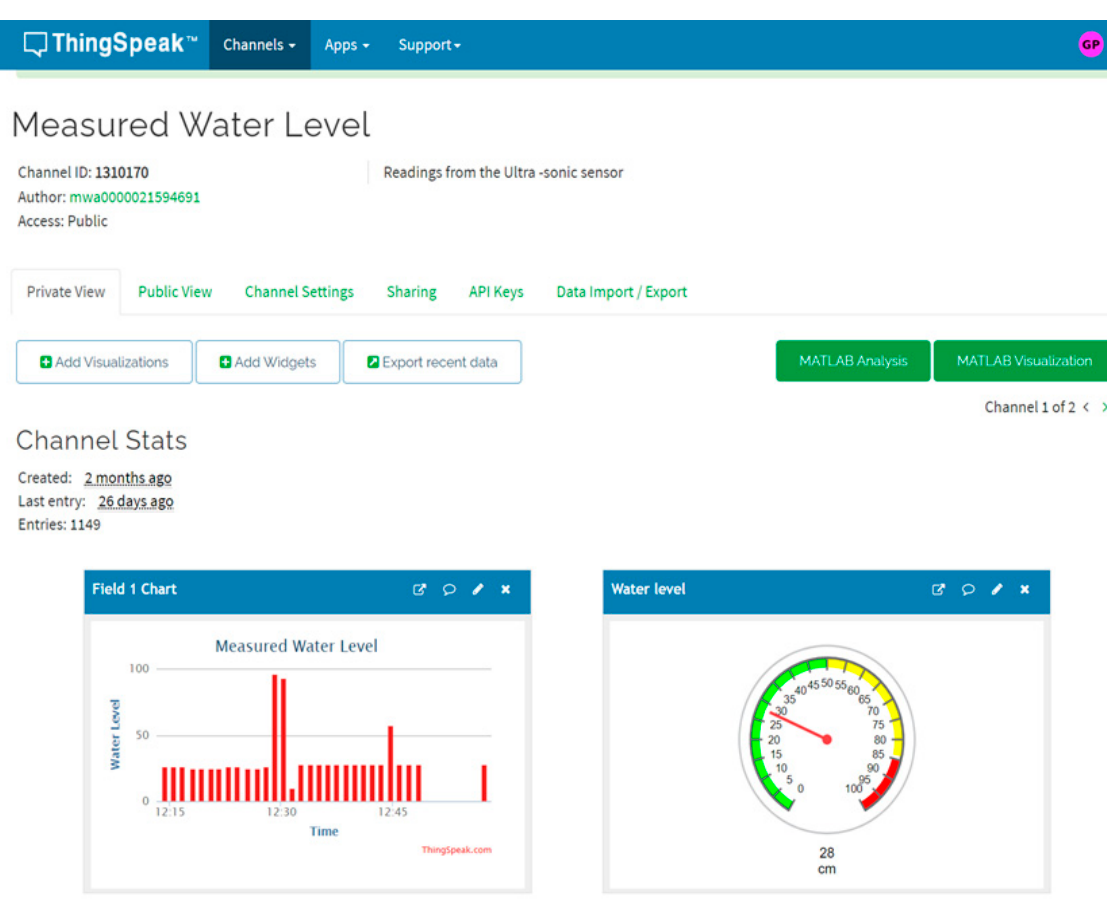
Figure 9. An example database from the ultrasonic sensor with the Arduino system via ThingSpeak cloud.